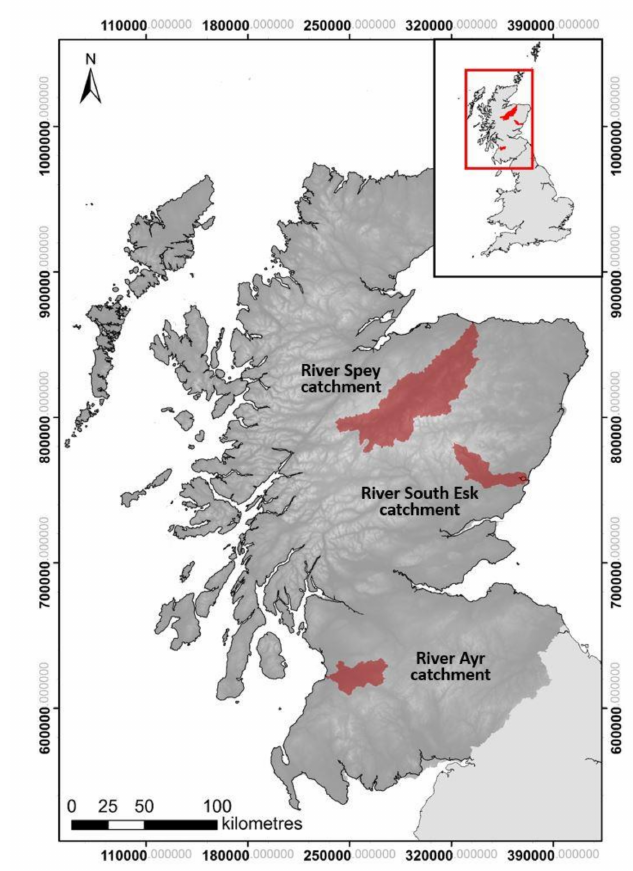
Figure 1. Location of the three study catchments in Scotland,